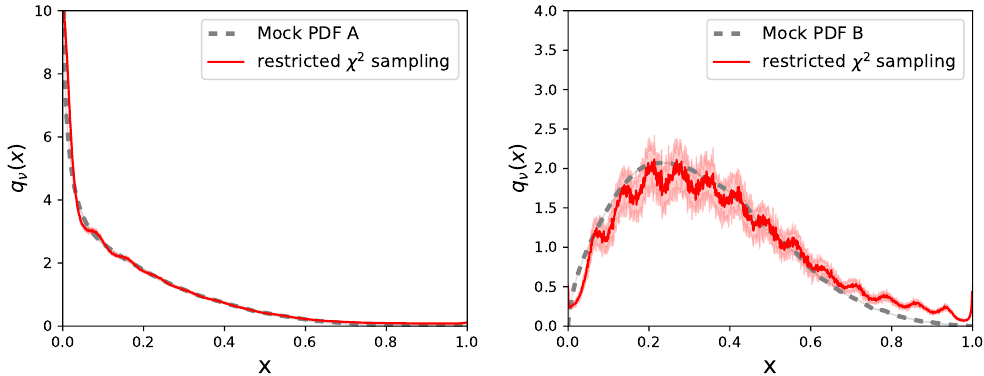
Figure 20 . Reconstructed PDF (red dashed) from restricted sampling of the (cid:31) 2 functional based on N (cid:23) = 100 Io(cid:11)e-time data points on the interval (cid:23) = [0 ; 100]. Mock scenario A is shown on the left, scenario B on the right. In this almost ideal setting, positivity alone provides a regularization that is su(cid:14)cient for a reasonable determination of the PDF of scenario A, while it is unable to suppress ringing artifacts in scenario